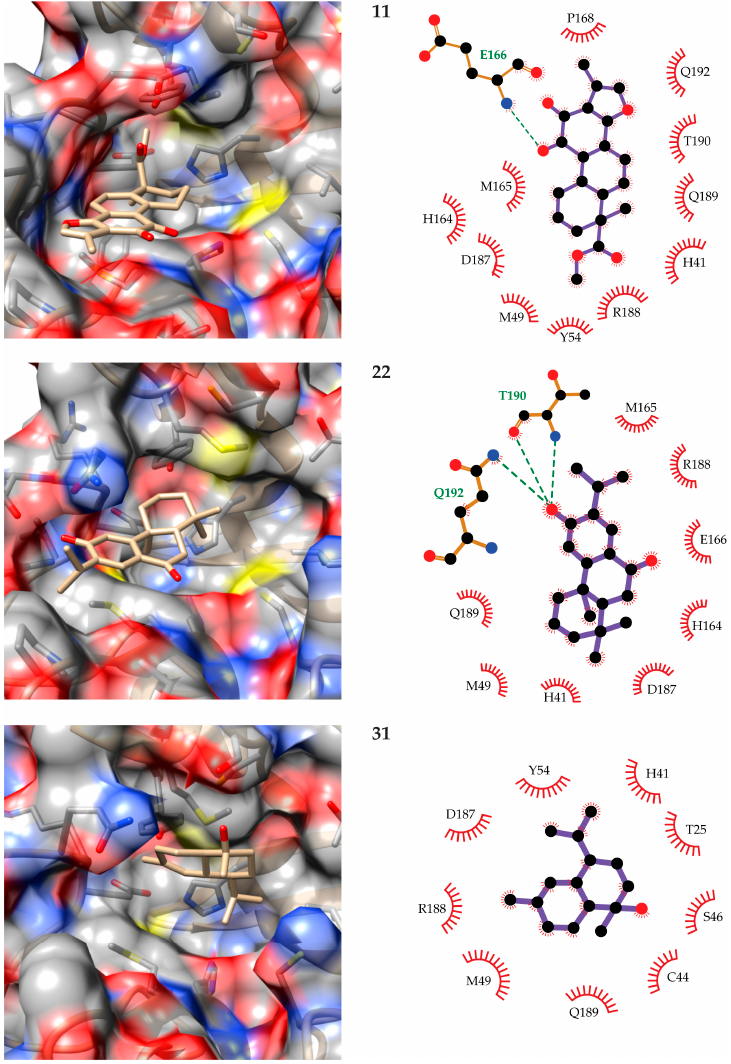
Figure 4. Predicted binding modes of 11 (Methyl tanshinonate, top), 22 (Sugiol, center), and 31 ( α -Cadinol, bottom) to the SARS-CoV-2 M pro (left) and diagrams of the observed ligand–receptor interactions (right). The receptor surface is colored by atom type: gray for carbon, red for oxygen, yellow for sulfur, and blue for nitrogen. All atoms are represented only for amino acids forming hydrogen bonds with the ligands in the interaction diagrams. In these diagrams, hydrogen bonds are represented by dashed lines, carbon atoms are represented in black, and the rest of the atoms are colored as in the left images.